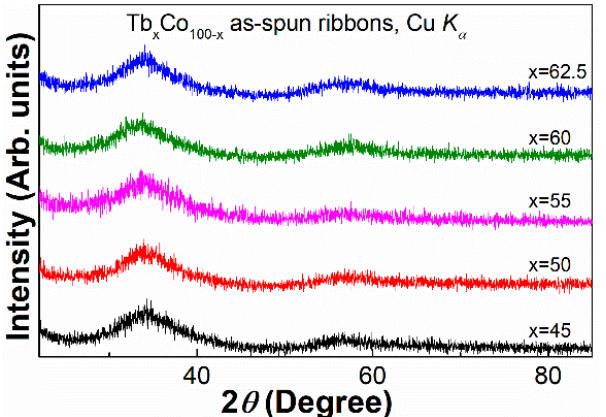
Figure 1. XRD patterns of the Tb x Co 100 − x (x = 45, 50, 55, 60, 62.5) as-spun